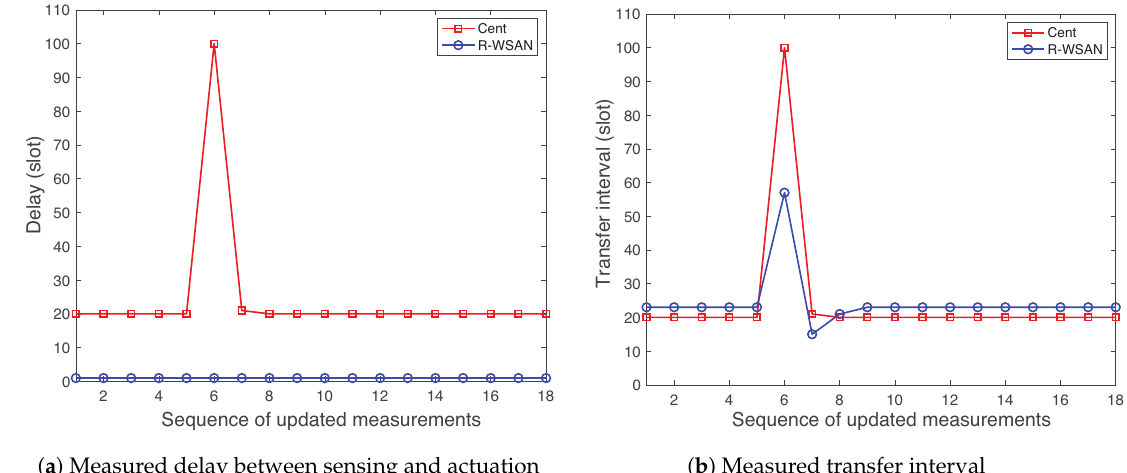
Figure 9. Effect of intra-cluster failure of R-WSAN and the centralized protocol as a function of sequence of updated measurements. R-WSAN provides the robust delay and transfer interval performance against the intra-cluster link